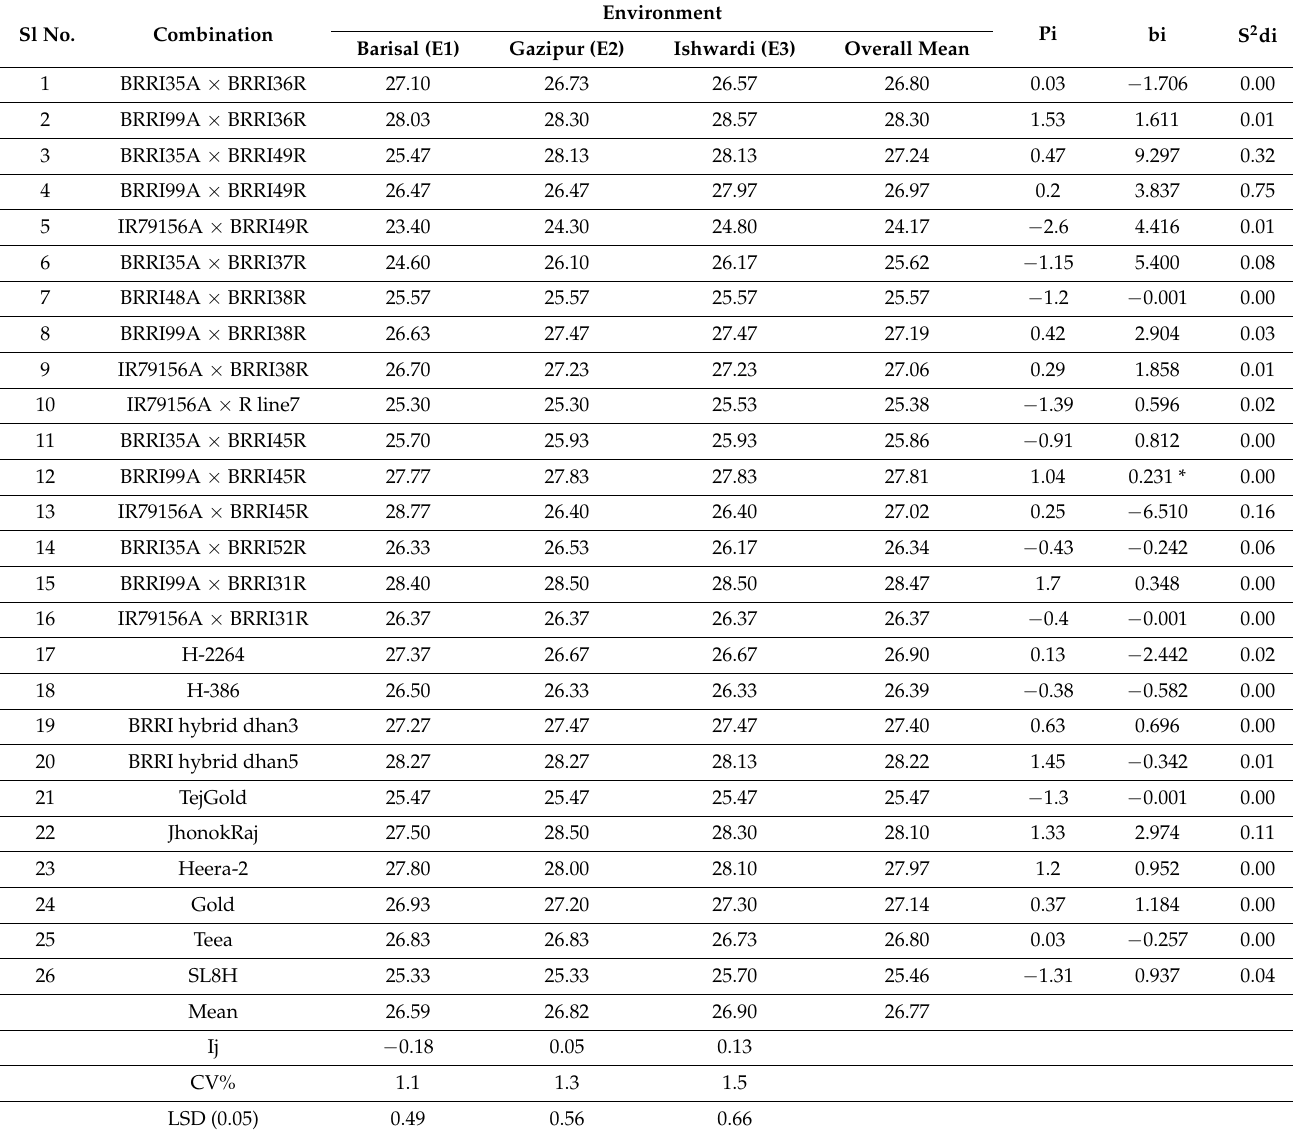
Table 10. Stability analysis for the thousand-grain weight of 26 hybrid combinations at three